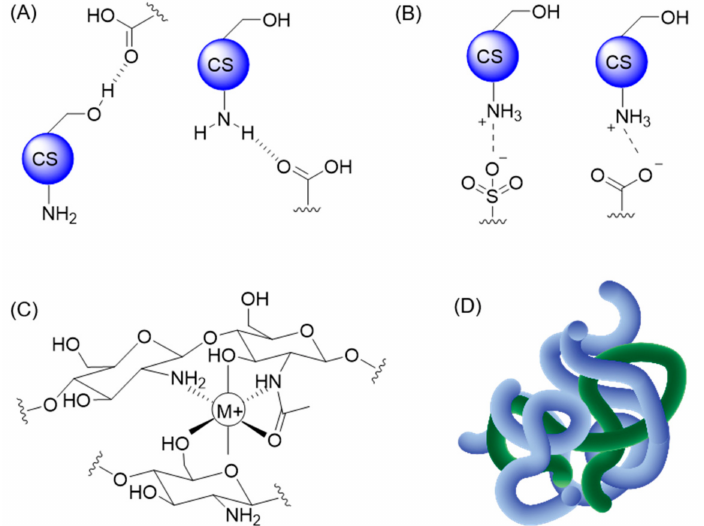
Figure 7. Examples of non-covalent interactions with CS: ( A ) H-bonding, ( B ) ionic interactions, ( C ) chelation, and ( D ) entanglement between multiple polymeric